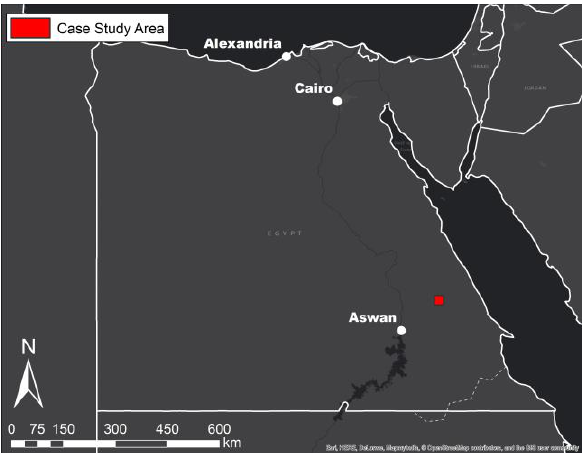
Figure 3. Location of case study in the Eastern Desert of Egypt (Basemap: Esri, HERE, DeLorme, MapmyIndia, © OpenStreetMap contributors, and the GIS user community).